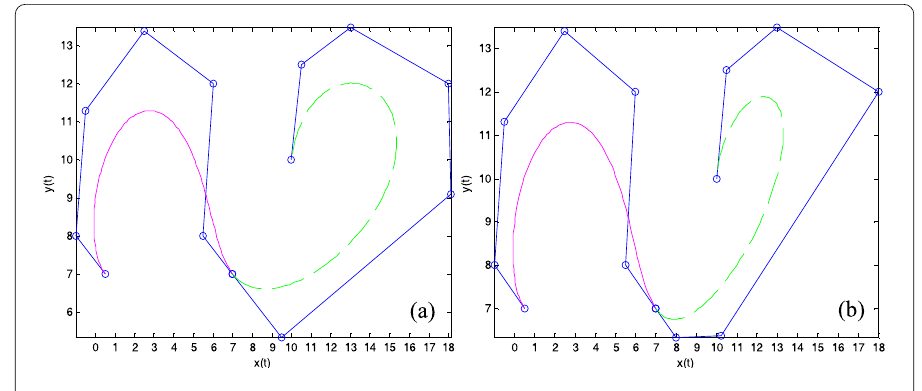
Figure 6 G 2 smooth continuity of sextic Q-Bézier